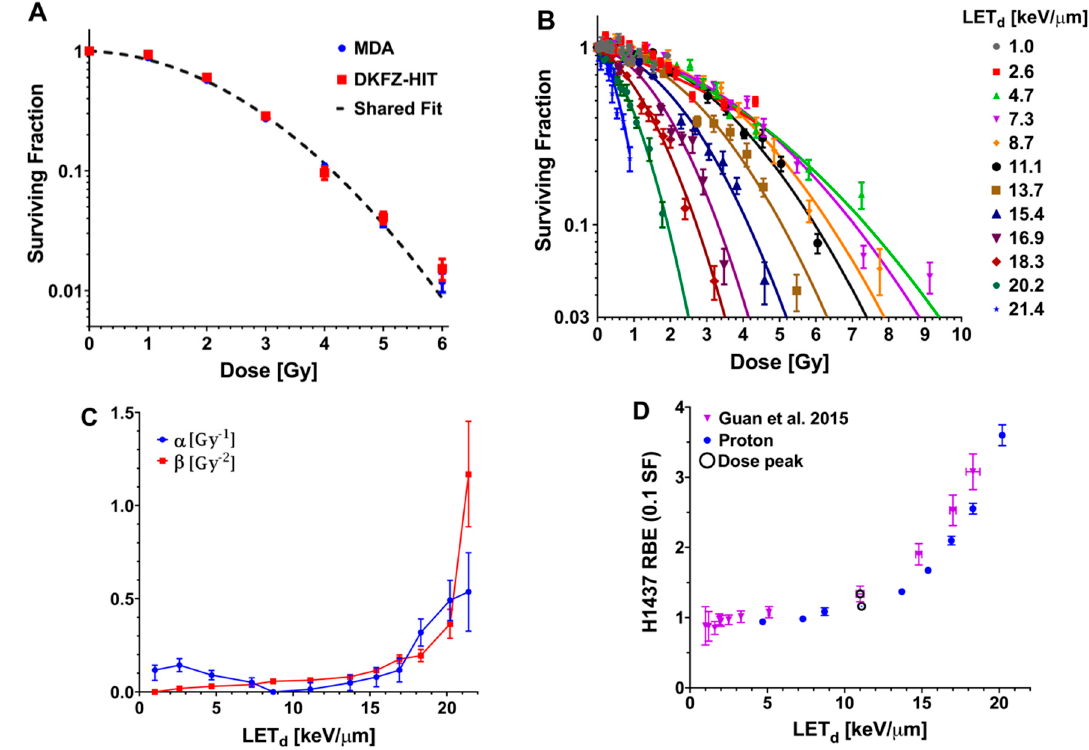
Figure 1. ( A ) The clonogenic survival of two lines of H460 non-small cell lung cancer cells exposed to 6 MV photons was found not to be statistically different between cells obtained from LGC Standards GmbH (Wesel, Germany) and irradiated at Deutsches Krebsforschungszentrum (DKFZ; green), and H460 cells purchased from the American Type Culture Collection (Manassas, VA, USA) and exposed at MD Anderson Cancer Center (MDA; red). p < 0.0001; Extra sum-of-squares F test. ( B ) High- throughput clonogenic assay results from proton (80.04 MeV) irradiations performed at the Heidelberg Ion Therapy Center for the H1437 non-small cell lung cancer cell line. The H1437 surviving fraction was found to decrease with increasing proton linear energy transfer (LET). Error bars are standard error of the mean. ( C ) α (blue) and β (red) values calculated by fitting the H1437 proton survival data to the linear-quadratic model. ( D ) Relative biological effectiveness (RBE) versus LET d for H1437 cells exposed to protons (blue). RBEs were calculated at the surviving fraction of 0.1 (RBE (0.1 surviving fraction: SF)). Previously published H1437 data are shown for comparison (purple, 79.7 MeV protons). Error bars represent standard error.